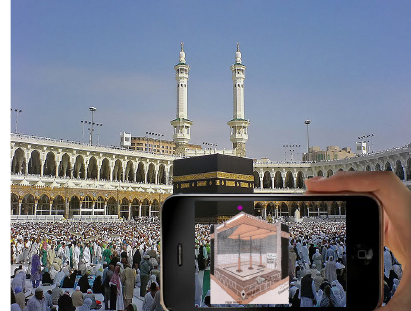
Figure 9. Utilizing handheld informative-based 3D that manifest physical world meeting the virtual world in the holy city of Mecca (Reffat, 2011).